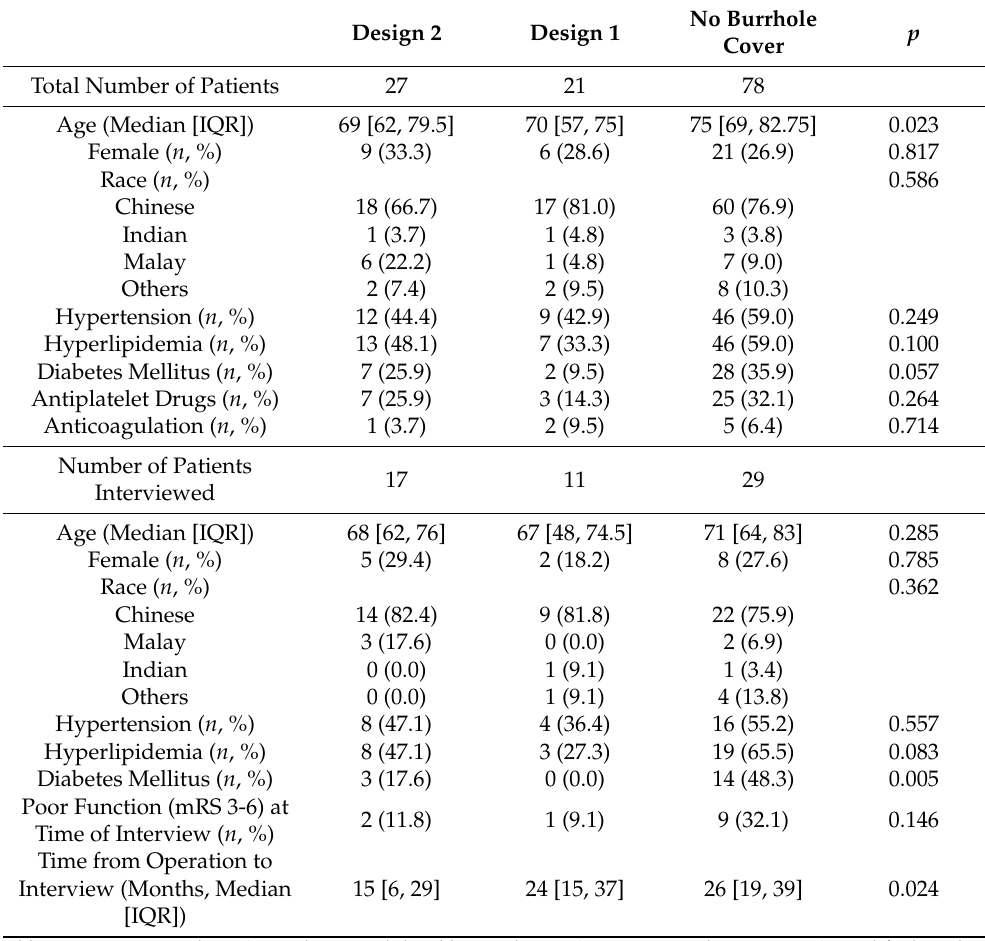
Table 2. Comparing the baseline characteristics of